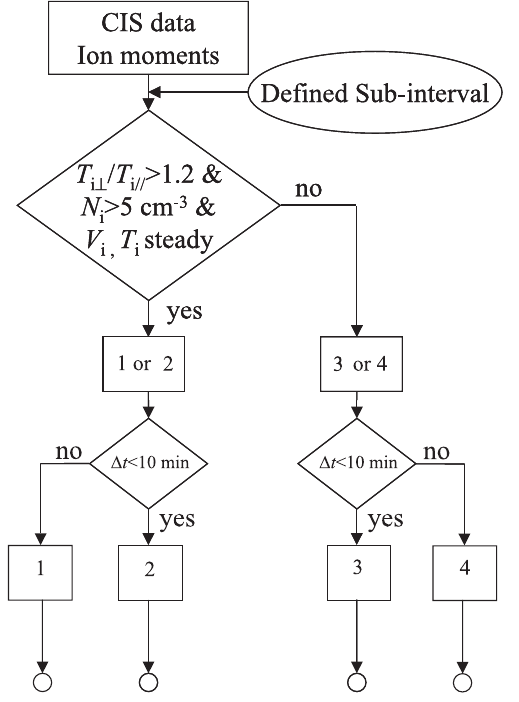
Fig. 2. Flowchart describing the procedure we have utilized to identify near-magnetopause time intervals: Eq. (1) magnetosheath proper, Eq. (2) magnetosheath transition layers, Eq. (3) magneto- spheric transition layers, and (4)